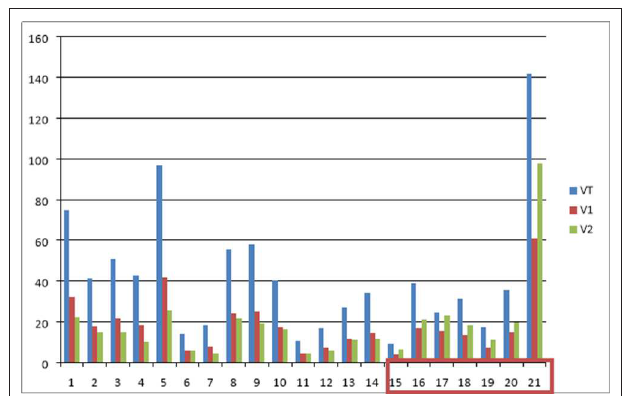
TABLE 1 | Patients’ characteristics.